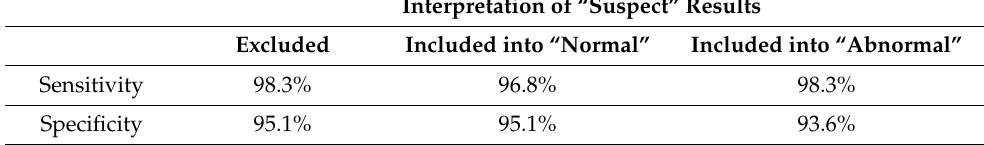
Table 3. Sensitivity and specificity of QST depending on the interpretation of suspect output of suprathreshold